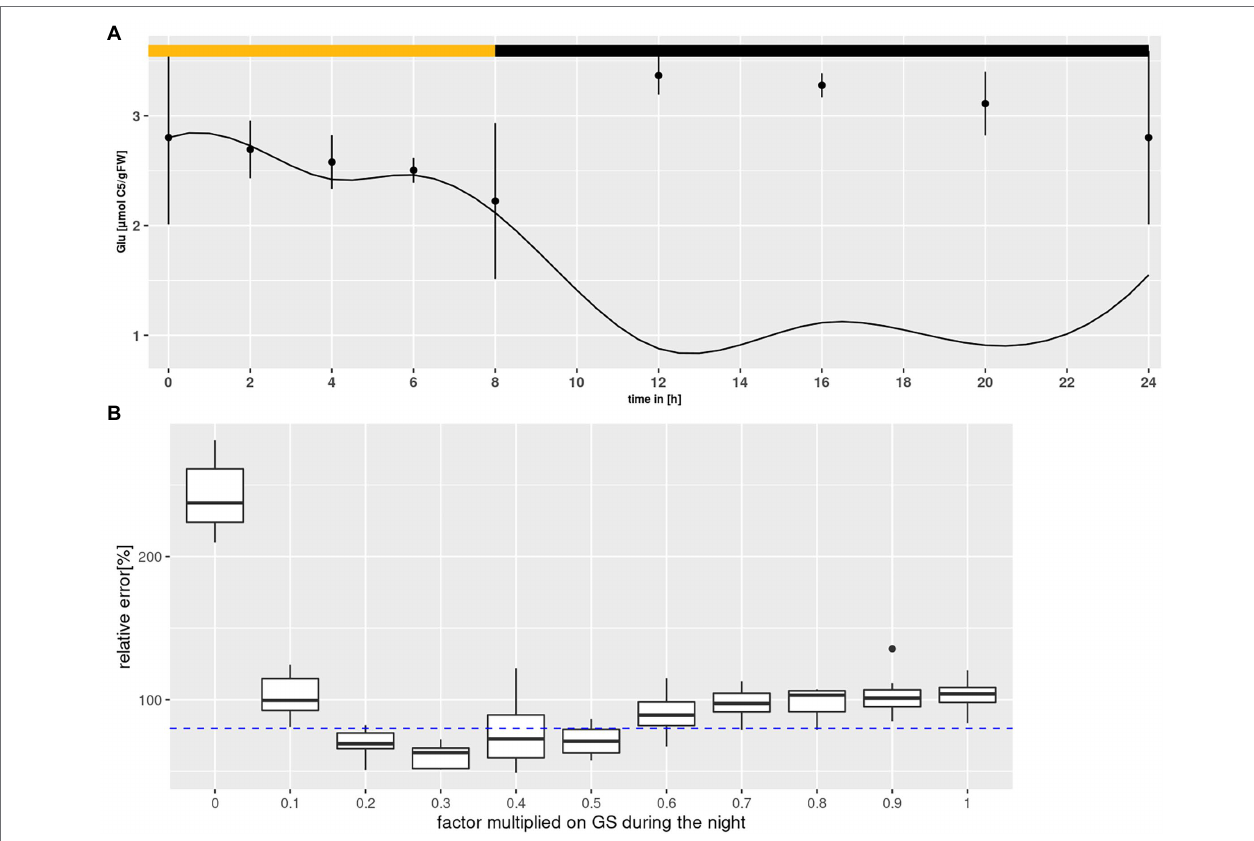
FIGURE 4 | Glutamine synthetase (GS) inactivation. (A) Diurnal course of glutamate for Col-0 at ambient CO 2 concentrations. Shown are mean with standard error ( n = 5). Lines represent the mean of 10 simulations. Light phase indicated by yellow bar and dark phase indicated by black bar. (B) Error plotted against the factor multiplied with GS activity during the night. Each boxplot represents 10 simulations for Col-0 at ambient CO 2 concentrations. The dashed line indicates the threshold at which results for simulations of all states were accepted (see text for